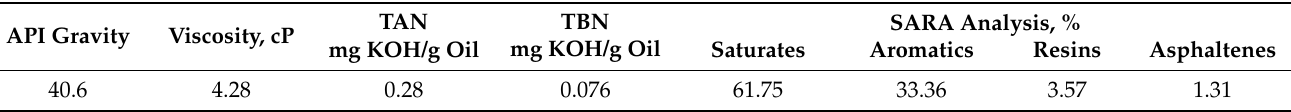
Table 2. Properties of the crude oil at surface conditions.